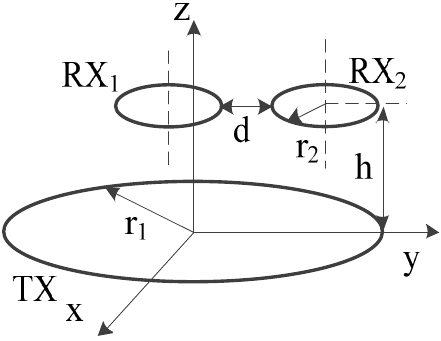
Figure 3. Overall sketch map showing the positions of the transmitting and receiving coils.